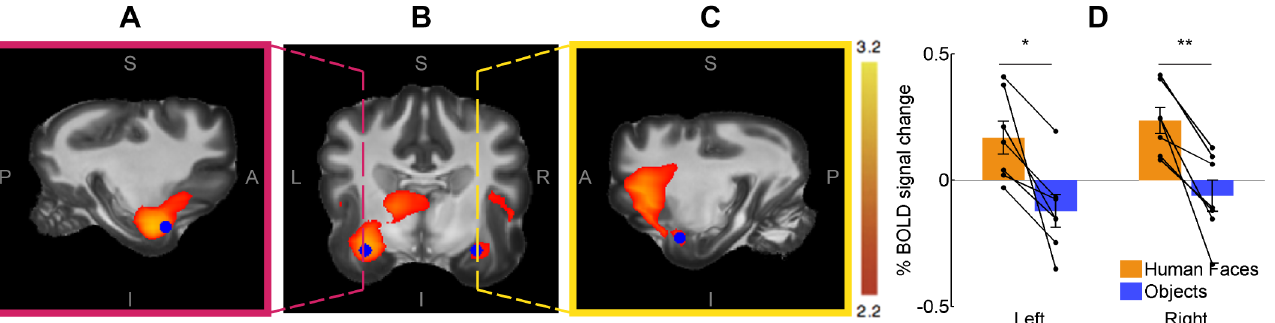
Fig 4. Bilateral temporal cortex in the contrast Human faces > Objects (n = 7). The cerebral activity focused in the temporal cortex is shown overlaid on the Datta atlas [24]. A. Left hemisphere in a sagittal slice. B. Bilateral temporal cortex in a coronal slice. C. Right hemisphere in a sagittal slice. Dashed lines in B show the location of the sagittal slices shown in A and C. D. BOLD signal change in a sphere of 5 mm radius sphere centered at the voxel with maximum z value for the both hemispheres (blue spheres show in A, B and C). Oblique lines represent the data of each participant and vertical lines represent standard error. * < 0.05; ** <